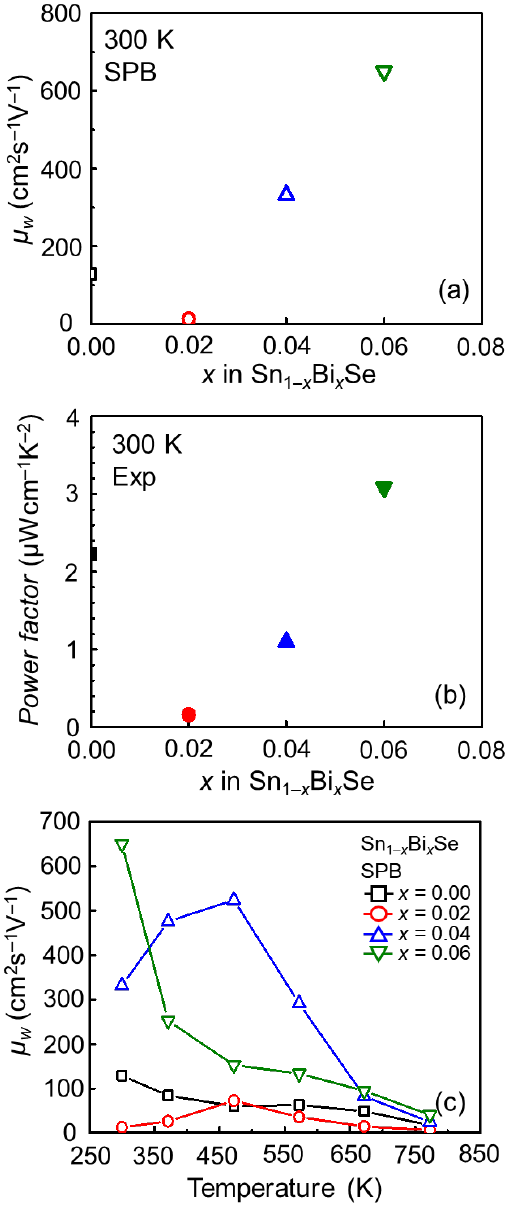
Figure 3. ( a ) Calculated weighted mobility ( µ W ) varying with x in Sn 1 − x Bi x Se ( x = 0.00, 0.02, 0.04, and 0.06) at 300 K, ( b ) experimental power factor varying with x in Sn 1 − x Bi x Se ( x = 0.00, 0.02, 0.04, and 0.06) at 300 K [18], and ( c ) calculated µ W for Sn 1 − x Bi x Se ( x = 0.00, 0.02, 0.04, and 0.06) varying with temperature (300–773 K).